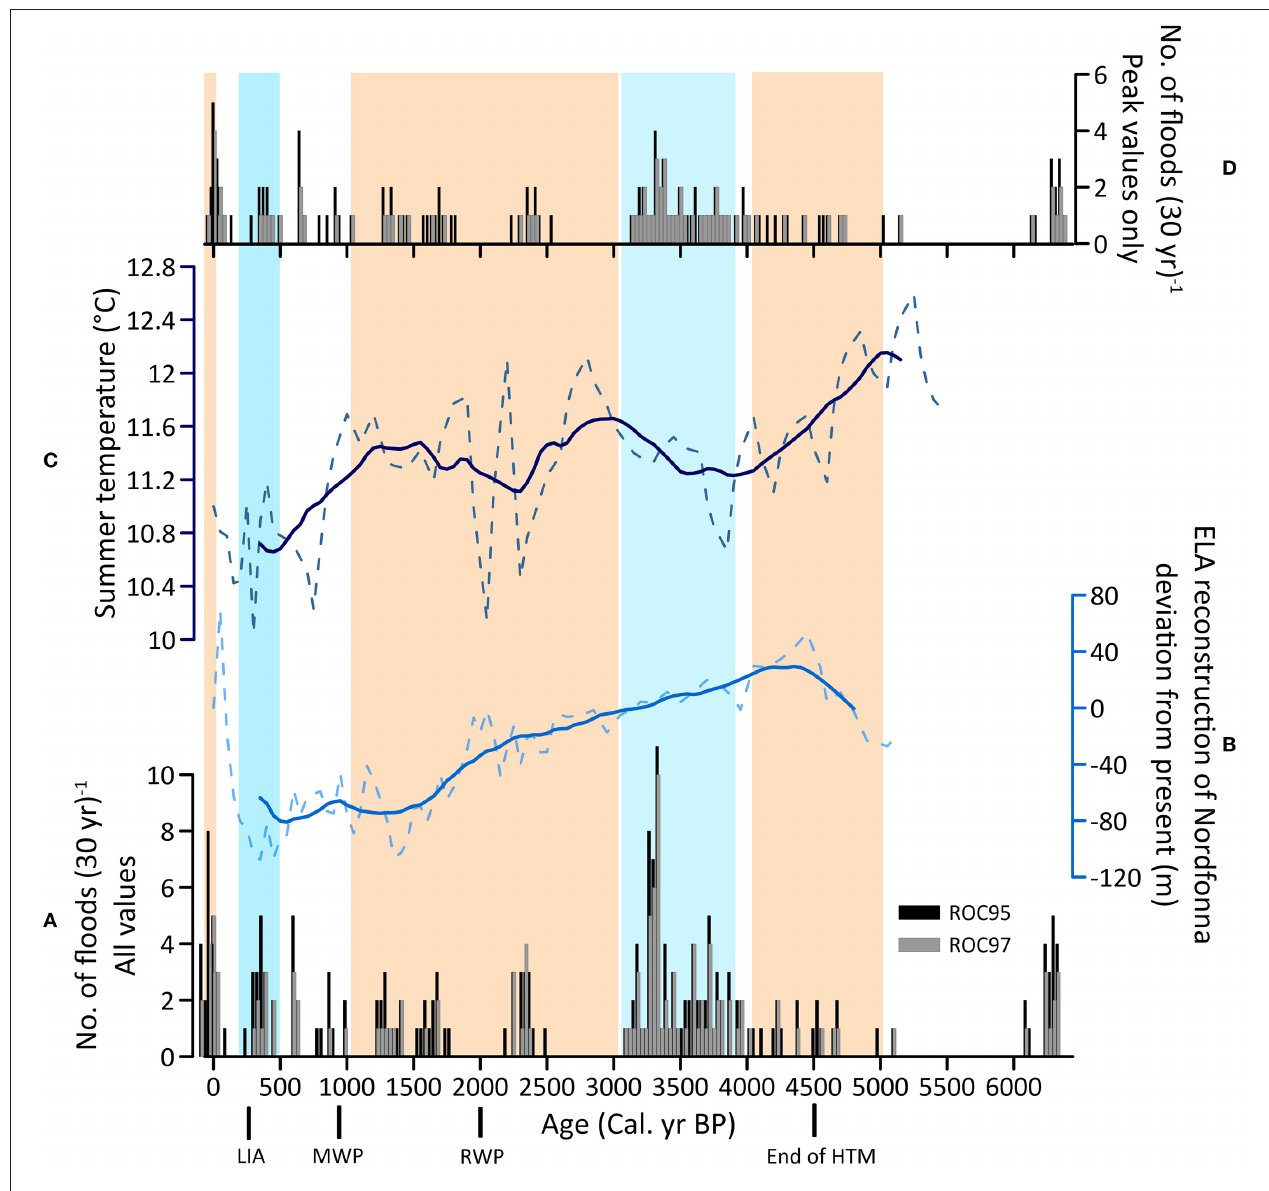
FIGURE 13 | (A) Flood frequency diagram based on the rate of change (ROC) of magnetic susceptibility (MS) for both the SA16/17 and SAD616 cores using all values above the 95th (black) and 97th (gray) percentiles. (B) Glacier reconstruction of Nordfonna—located < 17km north of Buerdalen valley—as evident from altitudinal shifts in the local equilibrium line altitudes (ELAs) compared with present day (Bakke et al., 2005b). (C) Local summer temperature reconstruction from Vestre Øykjamyrtjørn < 40km southwest of Sandvinvatnet (Bjune et al., 2005). (D) Flood frequency diagram based on ROC of MS for both the SA16/17 and SAD616 cores using only the peak values above the 95th (black) and 97th (gray) percentiles. The orange and blue markings represent warm and cold periods delineated by Seppä et al. (2009).